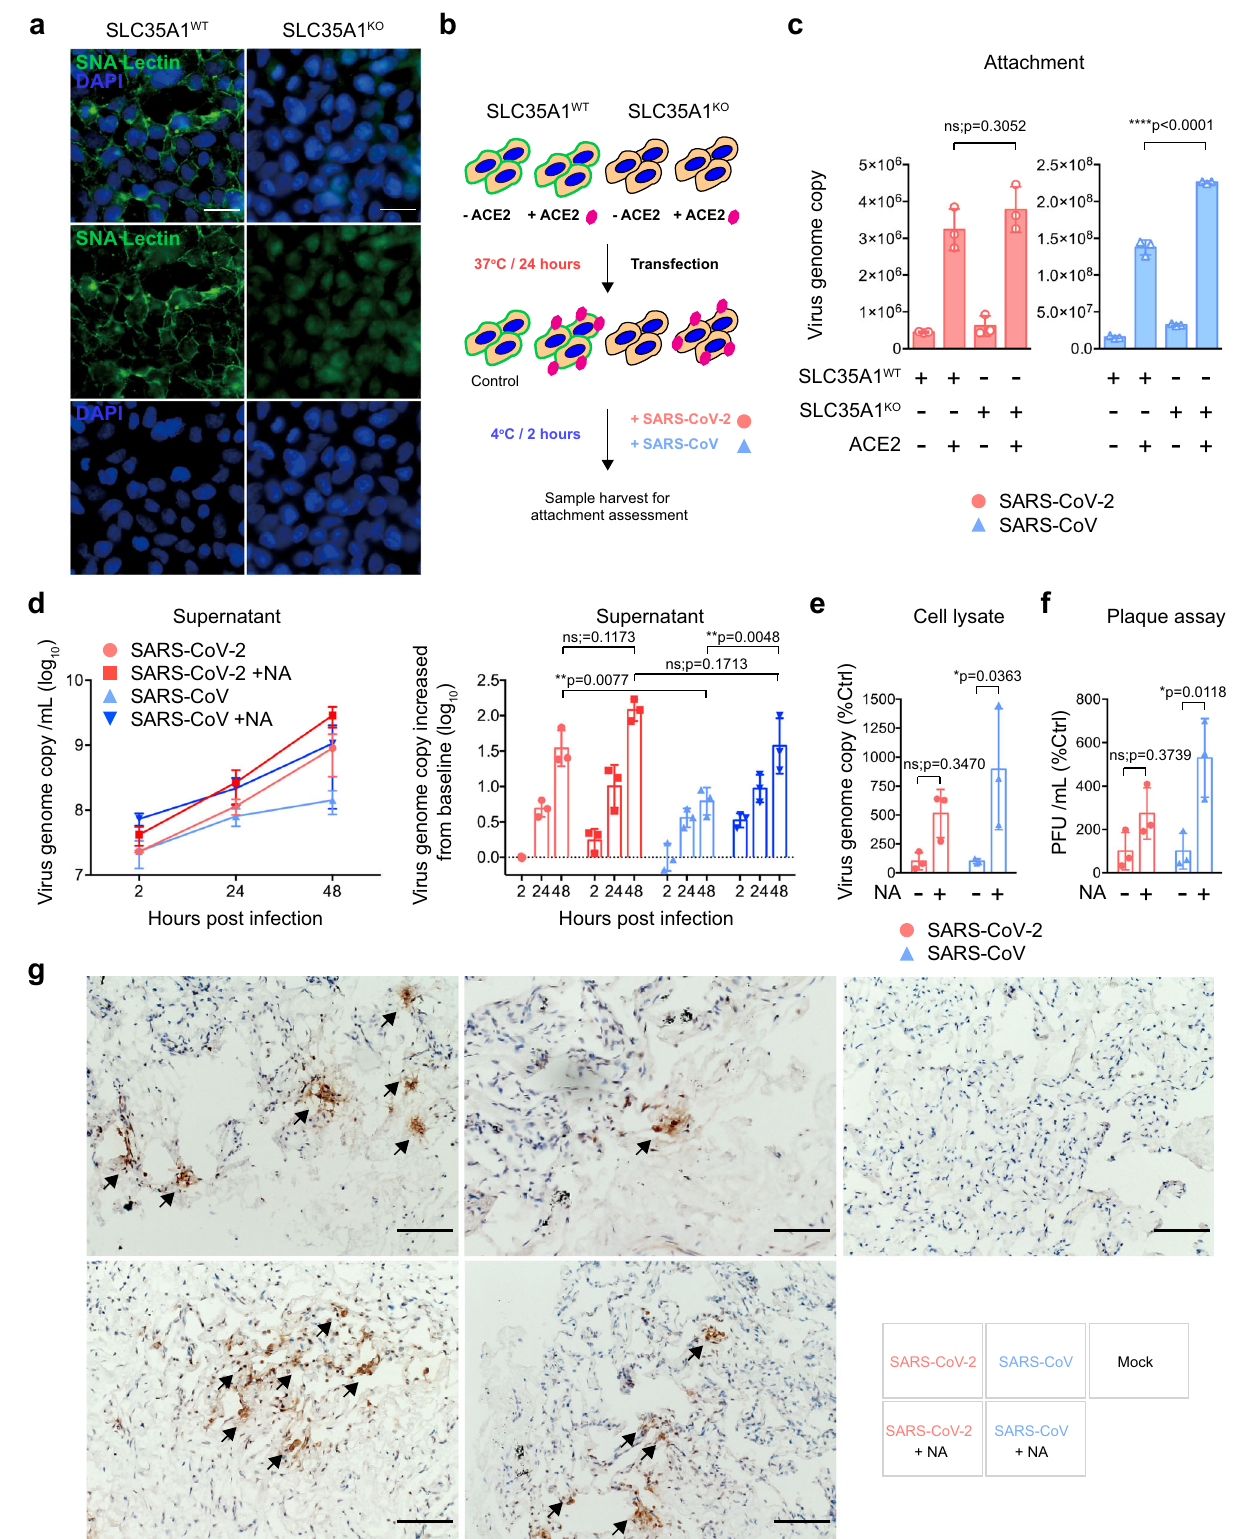
SARS-CoV-2 replication, we transfected the ACE2 mutant con- structs into BHK21 cells and inoculated the cells with SARS-CoV- 2. Samples were harvested at 24 hours post infection and virus replication in the cell lysates and supernatants were quanti fi ed with qRT-PCR. The results were largely in line with those obtained in the pseudovirus entry assays. In